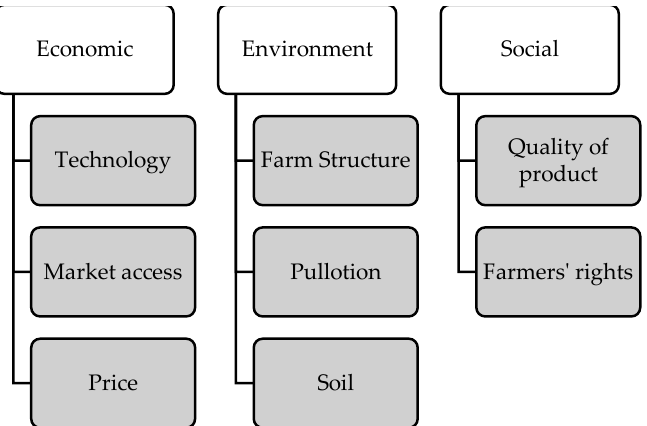
Figure 7. Most recommended indicators for sustainability in agriculture.